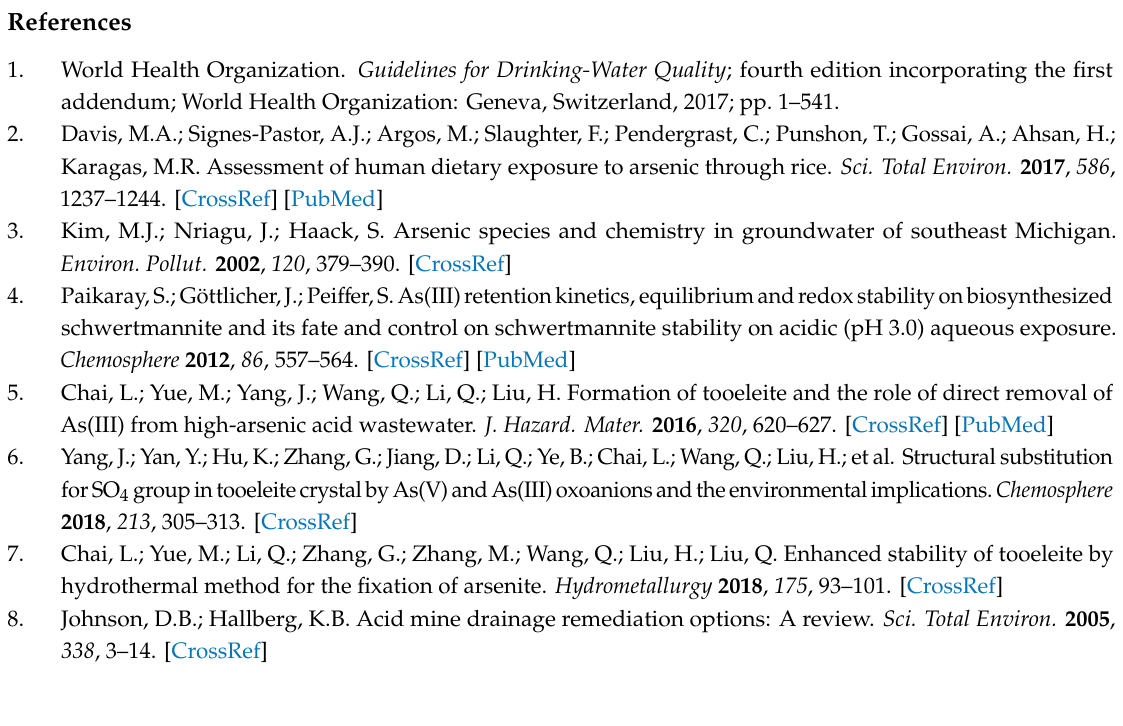
Figure S1: Change of the mole ratios between the solution components in the tooeleite dissolution at 25 ◦ C and initial pH 2 or 12, Table S1: SEM-EDS analysis results of tooeleite before and after